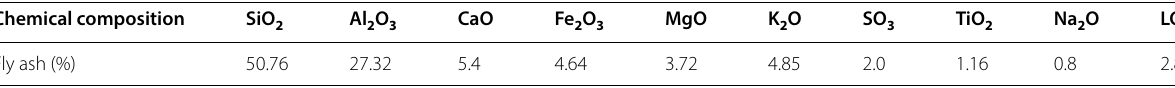
Table 2 Chemical compositions of fly ash.